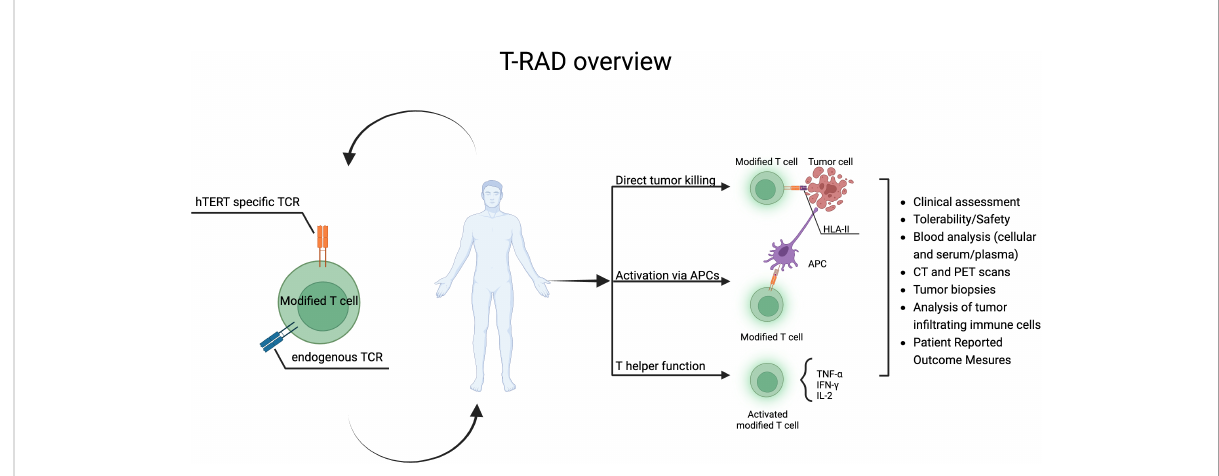
FIGURE 7 T-RAD clinical study overview. Created using